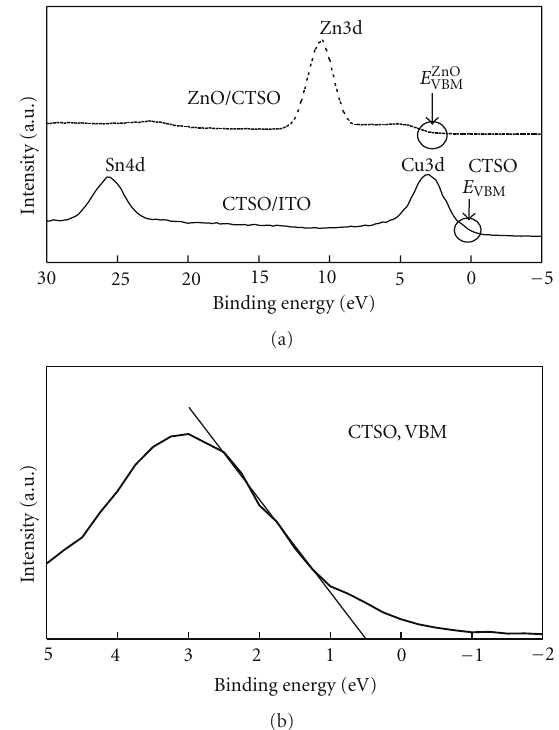
Figure 10: (a) XPS spectra for the ZnO and CTSO films. The CTSO film was deposited under condition 1. (b) expanded spectrum near VBM for CTSO. The straight line in (b) is the linear extrapolation of the leading edge, and the intercept on the energy axis corresponds to the VBM position.